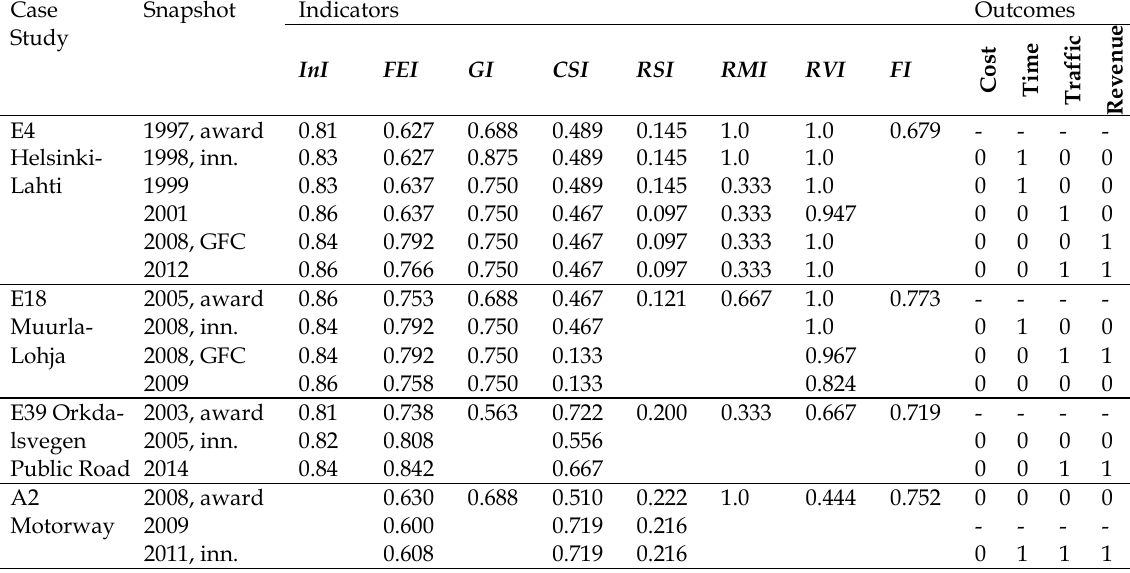
Snapshots for road projects in countries with a low impact of the GFC